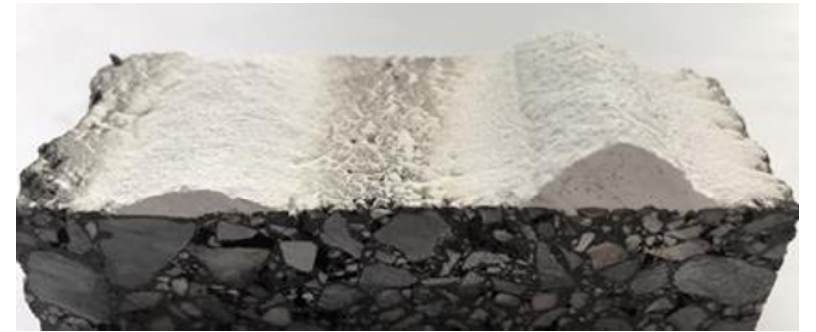
Fig. 3. Sprayed tracks on the surface of asphalt concrete, obtained at temperatures of working air of 300 K (left) and 433 K (right).